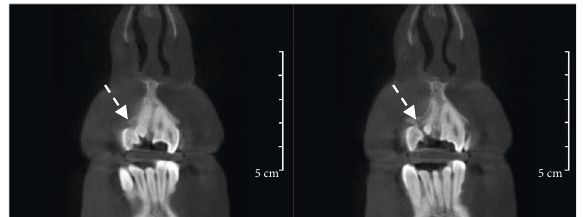
Figure 4: Plane of coronal CBCT sections of maxillary showing the separation level of the fused #11 and #12 (arrow).